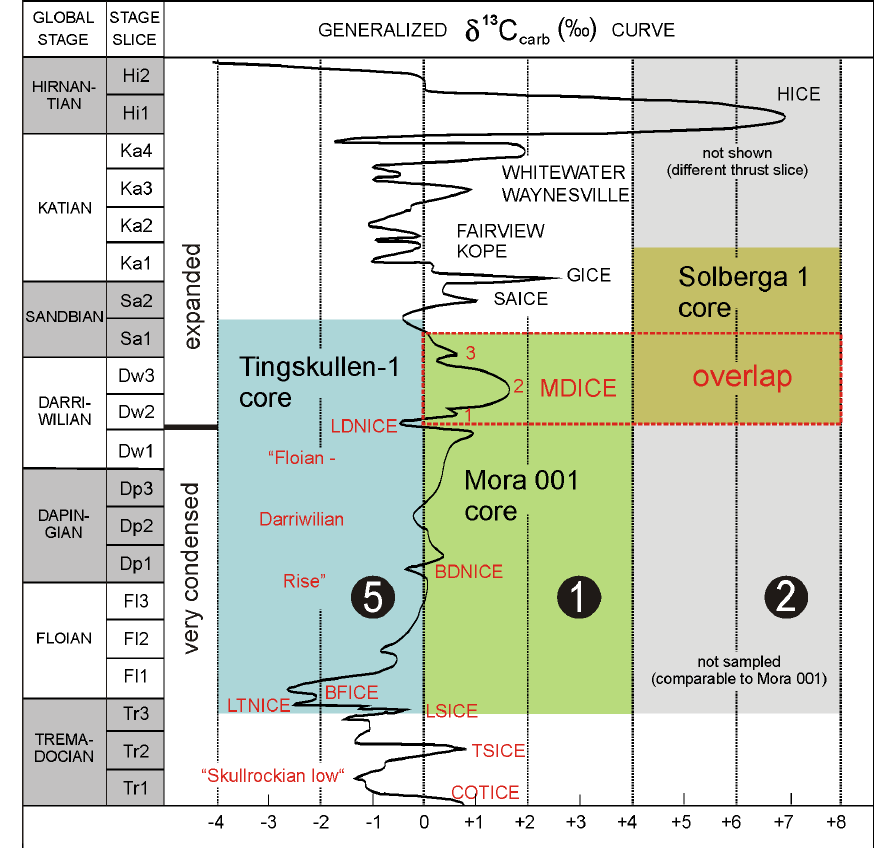
Fig. 1. Generalised δ 13 C curve for the Ordovician System. Modified from Bergstr(cid:246)m et al. (2009, fig. 2) by the addition of the SAICE (Leslie et al. 2011), and the δ 13 C events named in the present paper (COTICE, TSICE, LSICE, TNICE, BFICE and DNICE). The MDICE is characterised by a tripartite subdivision indicated by numbers 1(cid:150)3 for the individual smaller peaks. The informal terms (cid:145)Skullrockian Low(cid:146) and (cid:145)Floian(cid:150)Darriwilian rise(cid:146) is mentioned in the text. The three coloured blocks show the stratigraphic range of the sedimentary record in the Tingskullen-1, Mora 001 and Solberga 1 cores (the lower part of the succession in Solberga, which is comparable to that in the Mora section, was not sampled for this study and is indicated in grey), the encircled numbers refer to the corresponding location numbers shown in Figure